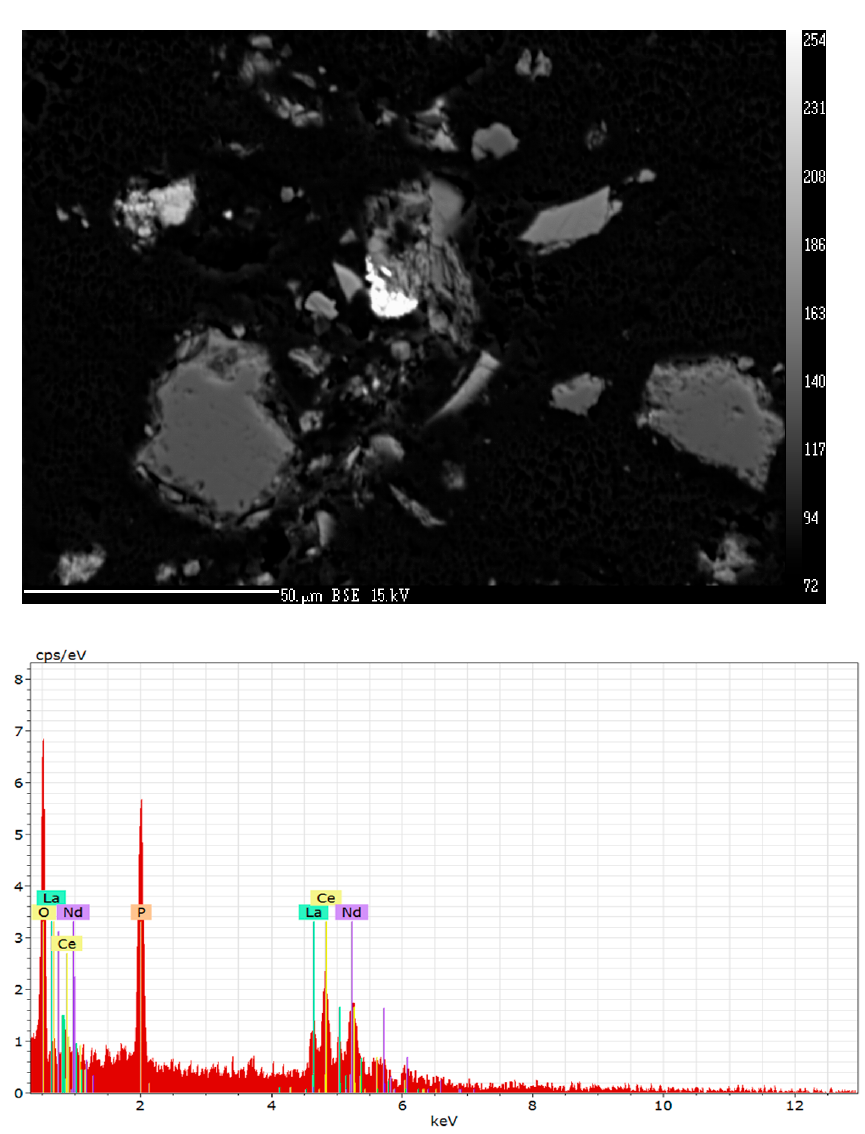
Figure 6. A close-up BSE image of the zircon grain (above) and EDS analysis (below). The star indicates a peak of the C which is coming from the carbon coating of the sample. Sample RIC 3.